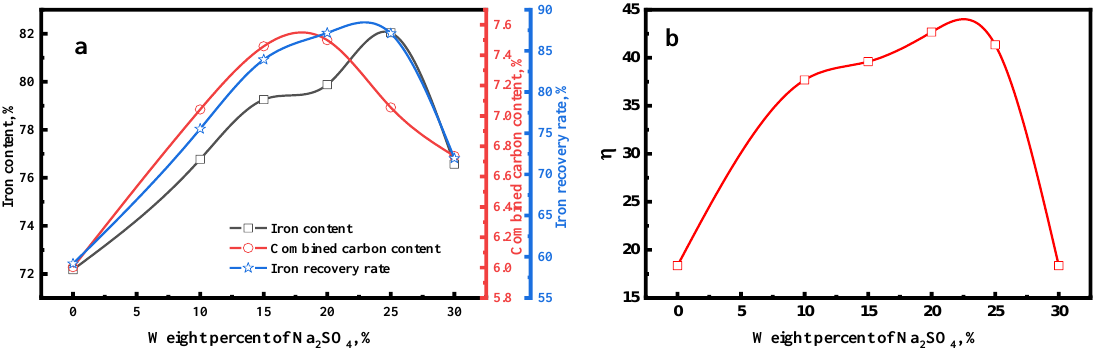
Figure 3. Effect of Na 2 SO 4 on the ( a ) magnetic concentrate and ( b ) carburization index of carburized pellet (carburized at 650 °C for 150 min).